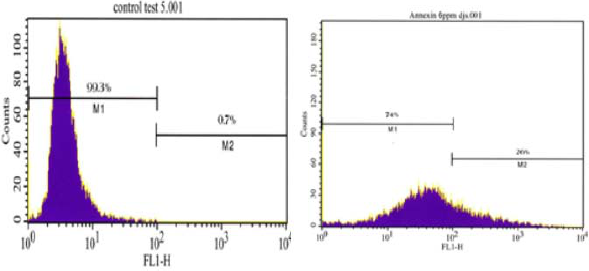
Figure 2: Annexin V Histogram Analysis showing Annexin positive cells in M2.